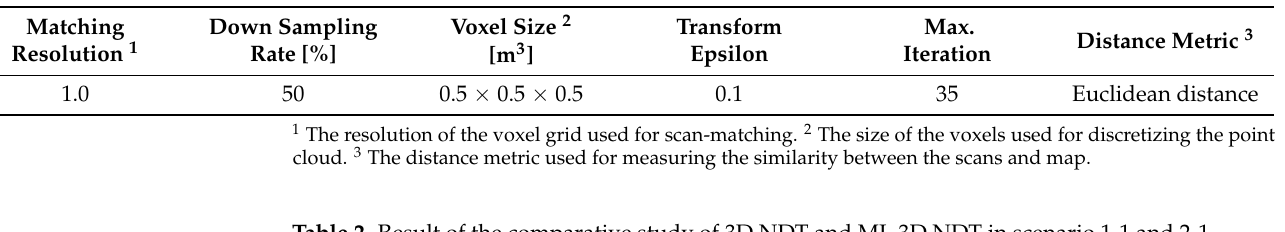
Table 1. Internal parameters of ML-3D NDT scan-matching with three layers.